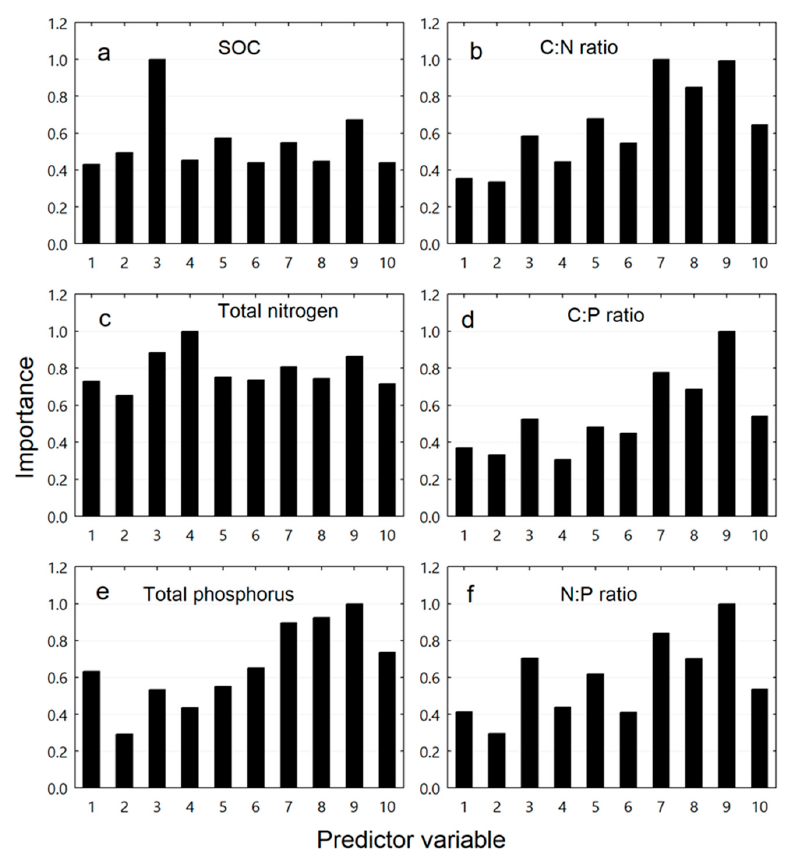
Figure 3. Random forest analysis showing the importance of variables for predicting SOC ( a ), total nitrogen ( c ), total phosphorus ( e ), and C:N:P stoichiometric ratios ( b , d , f ). The response variable is shown in each graph panel. Code for predictor variables: 1 = potential direct incident radiation (PDIR, MJ m − 2 d − 1 ); 2 = transmitted total radiation (TransTot, MJ m − 2 d − 1 ); 3 = warming index; 4 = number of stems in the understory ( N under ); 5 = number of species in the understory ( S under ); 6 = Shannon-Wiener index of the understory community ( H’ under ); 7 = ordination scores of axis 1 for understory plants (Axis1 under ); 8 = ordination scores of axis 2 for understory plants (Axis2 under ); 9 = ordination scores of axis 1 for trees ≥ 5 cm (Axis1 tree ); and 10 = ordination scores of axis 2 for trees ≥ 5 cm (Axis2 tree